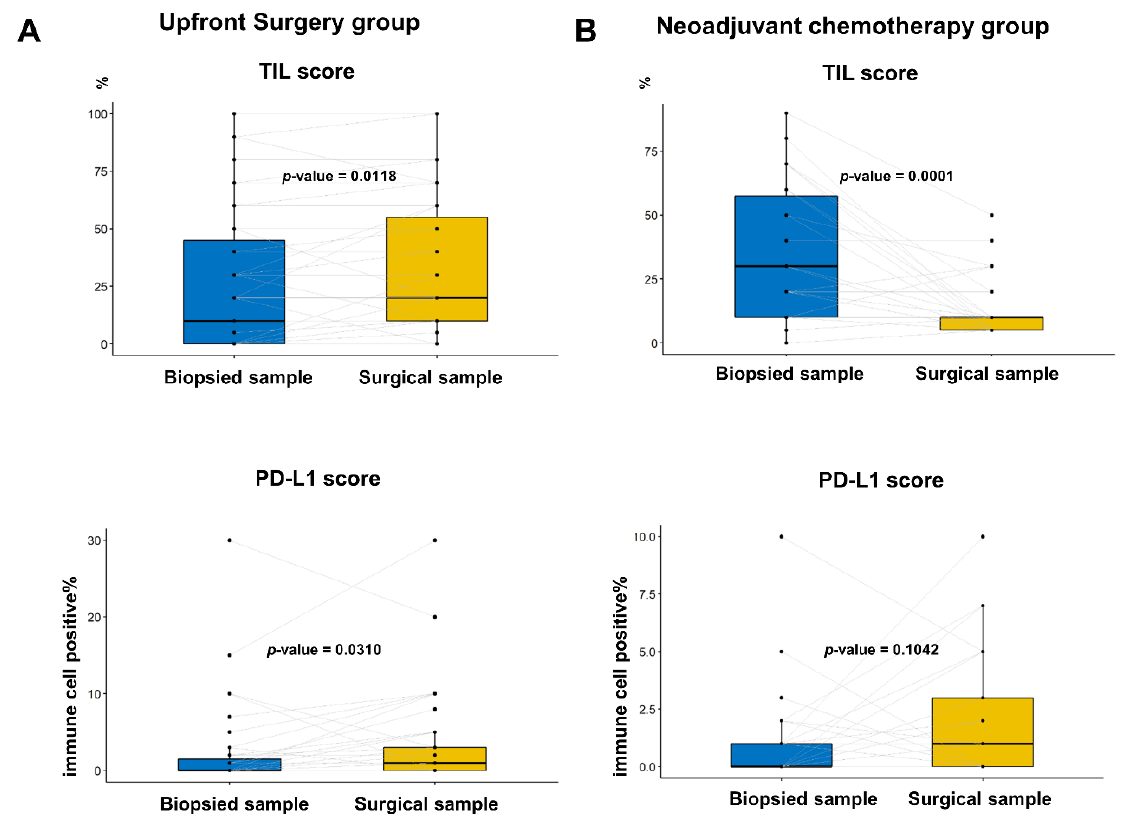
Figure 4. Comparison of percentage PD-L1 score and tumor-infiltrating lymphocyte (TIL)